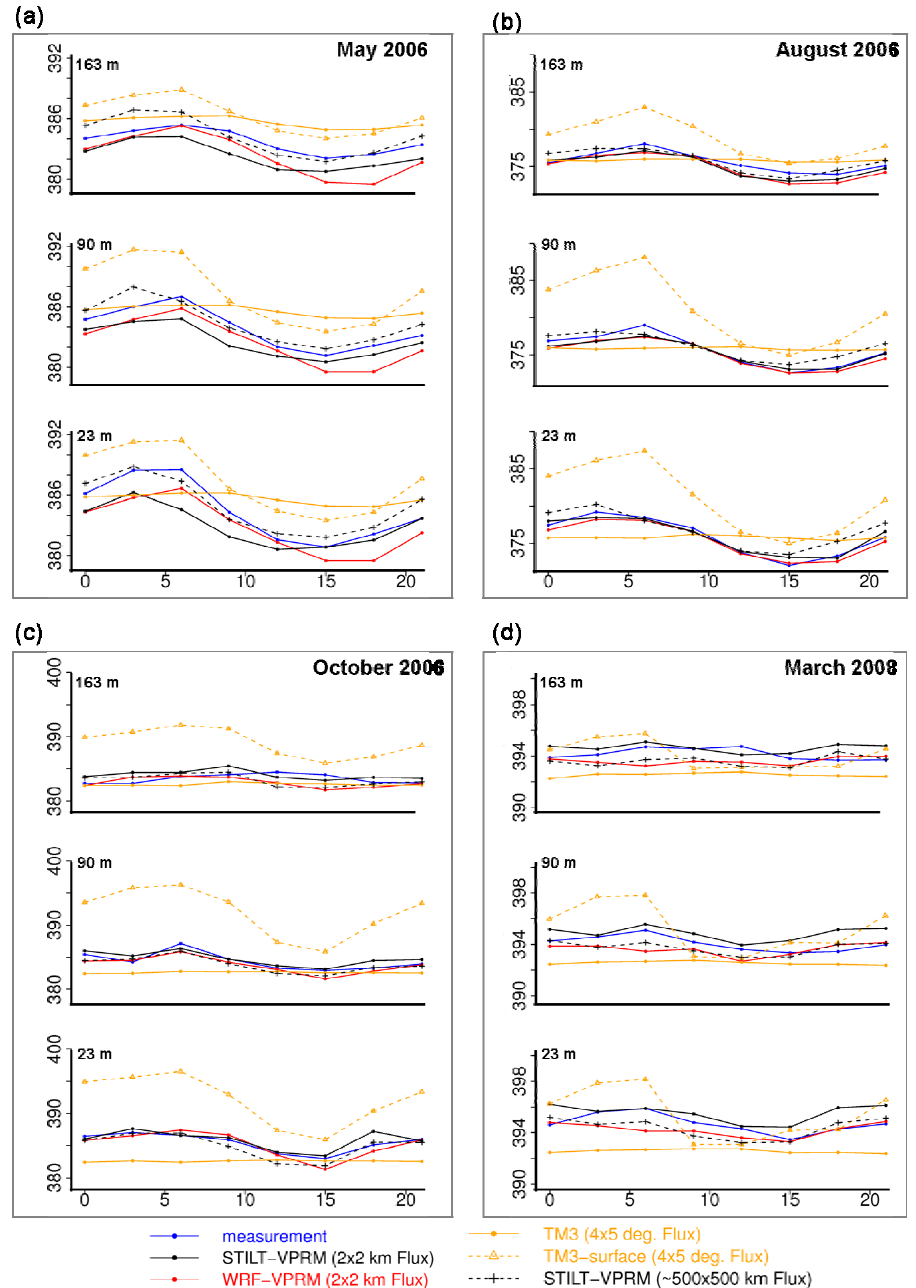
Fig. 13. Averaged diurnal cycle of observed and modeled CO 2 for OXK at different measurement levels and for different seasons: (a) May 2006 (spring), (b) August 2006 (summer), (c) October 2006 (autumn) and (d) March 2008 (winter). In each plots, top to bottom panels represents CO 2 at 163m, 90m and 23m respectively. x-axis: hour; y-axis: CO 2 concentration in